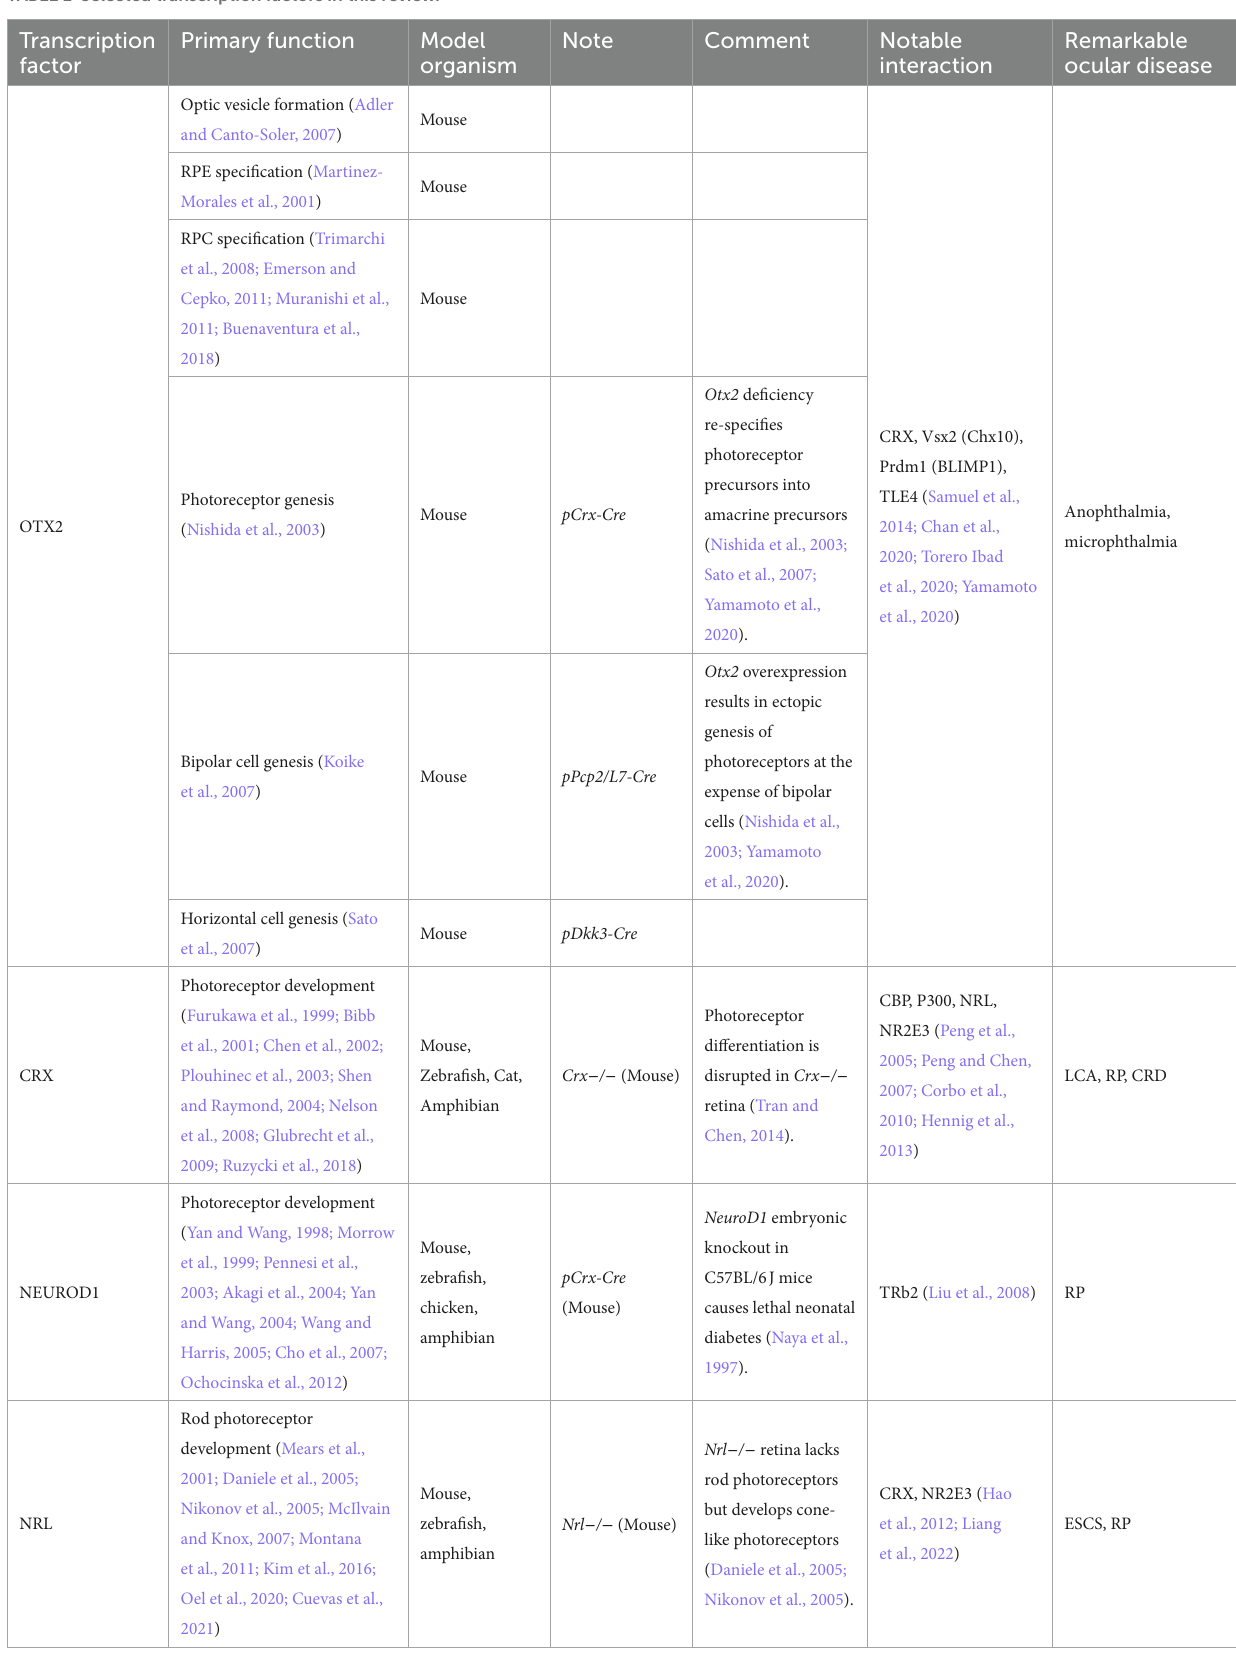
TABLE 1 Selected transcription factors in this